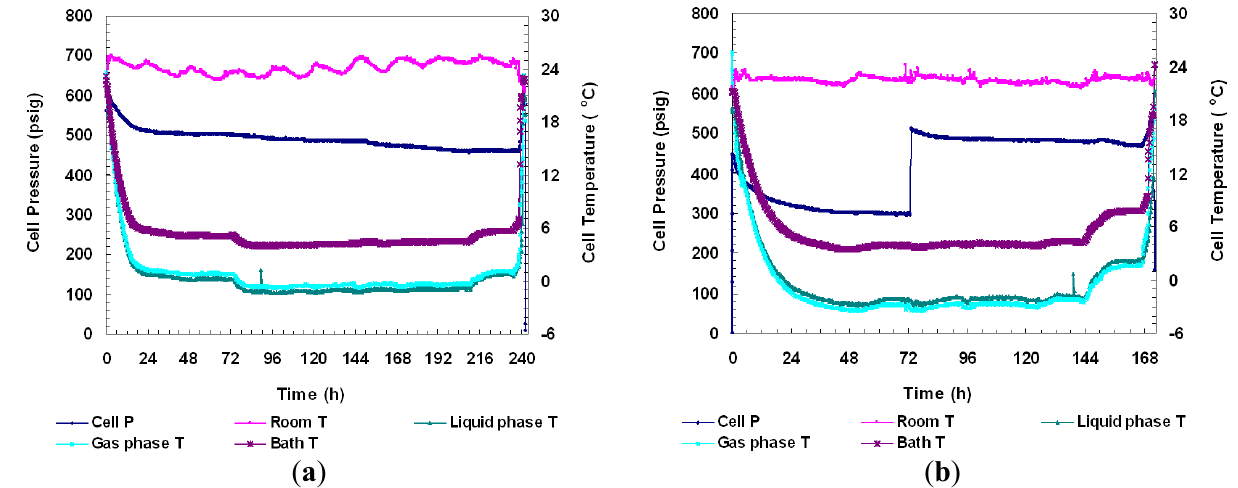
Figure 7. Cell P/T versus Time data plots for: ( a ) Run 2 at − 1 °C and 590 psig; ( b ) Run 3 at − 2 °C and 512